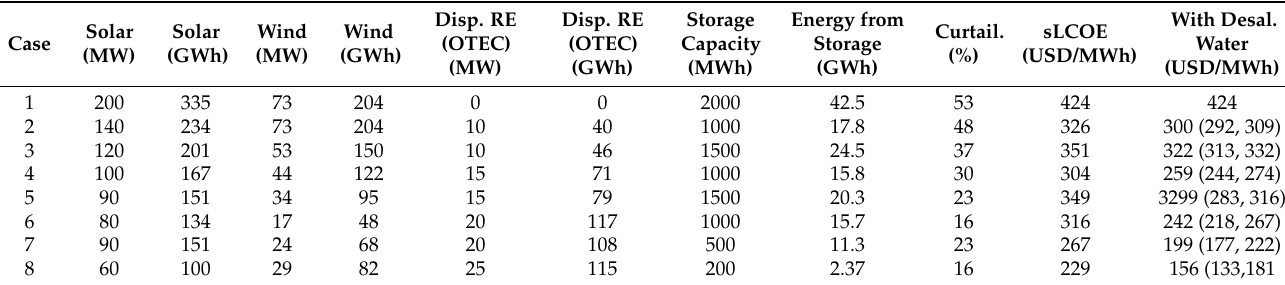
Figure 5. Necessary amount of storage capacity (in MWh) to allow demand to be satisfied for every hour of the year, and as a function of the installed wind and solar PV capacity. ( a ) With 10 MW of dispatchable renewable capacity and ( b ) with 20 MW of dispatchable renewable capacity. Peak system demand is 37 MW in this example. Note the difference in scale of a factor of two between the plots. Table 4. Sample results for sLCOE (USD/MWh) for different system configurations (solar PV, wind, dispatchable renewable, storage). Comparison is made with and without including the co-benefit of desalination. Dispatchable (Disp.); Desalination (Desal.); Curtailment (Curtail.) For the sLCOE with desalinated water, sensitivity to water price is included in parentheses, with the base case being USD 1.5/m 3 and in the range USD 1/m 3 to USD 2/m 3